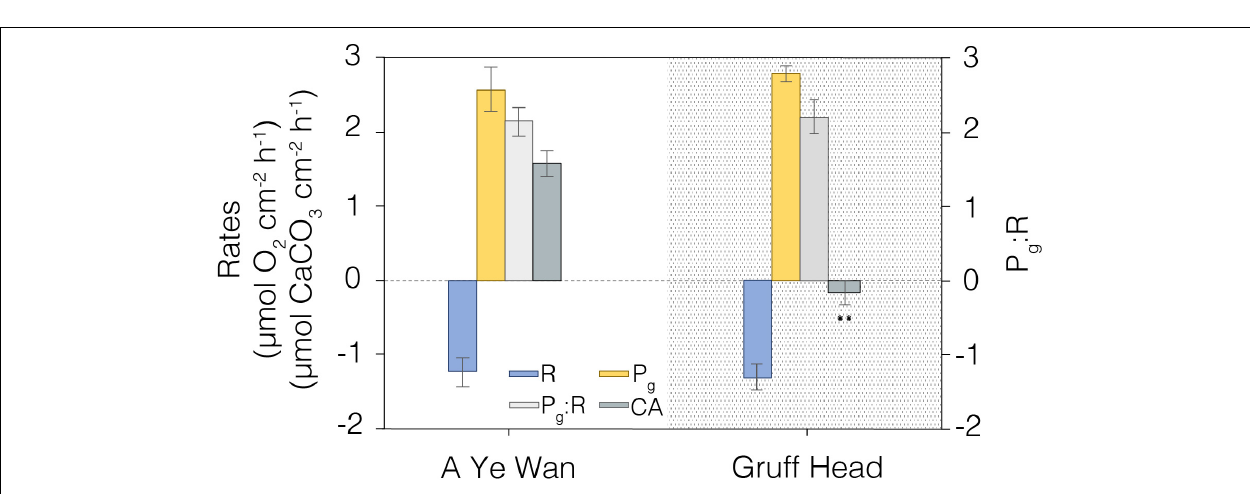
FIGURE 8 | Comparison of the average rate of O 2 production (gross photosynthesis) to the average rate of calcium carbonate production (daily calcification) in the laboratory aquaria (open circle) and in situ (closed circle) corals. The line shows the 1:1 relationship between the moles of O 2 produced and moles of CaCO 3